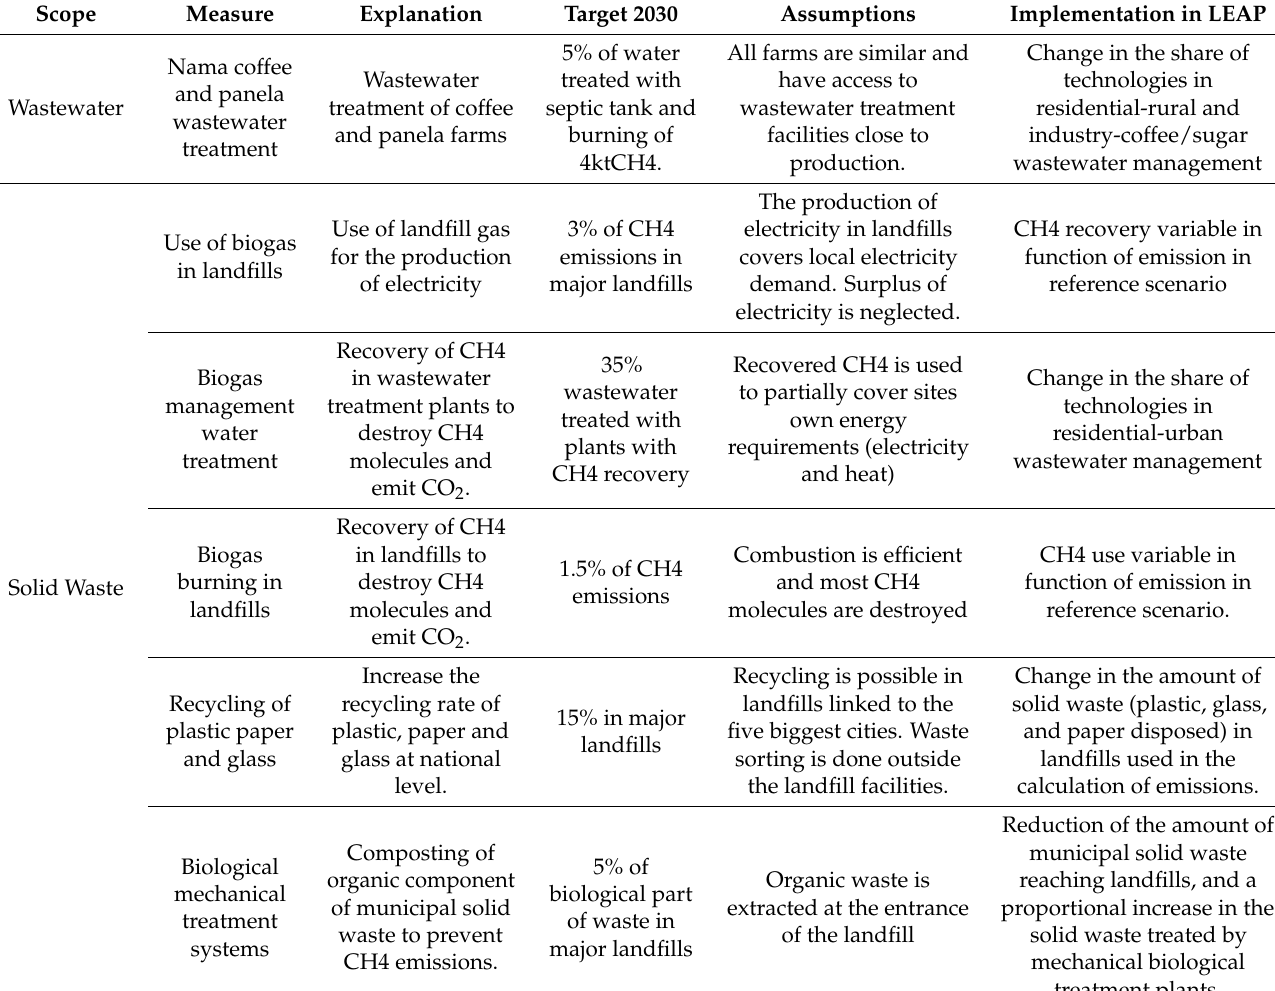
Table A5. Mitigation actions of AFOLU included in the mitigation